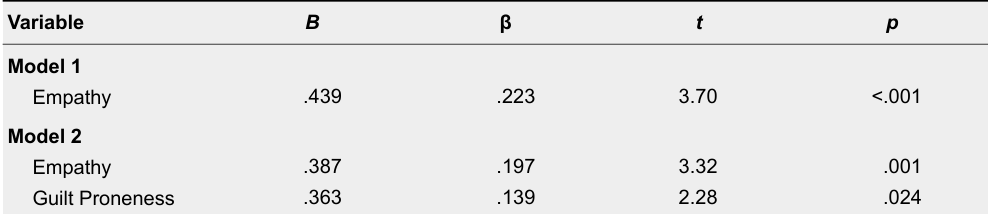
Stepwise Regression on Prosocial Behaviour in the Female Sample. Guilt Proneness Predicts Additional Variance Beyond Empathy.